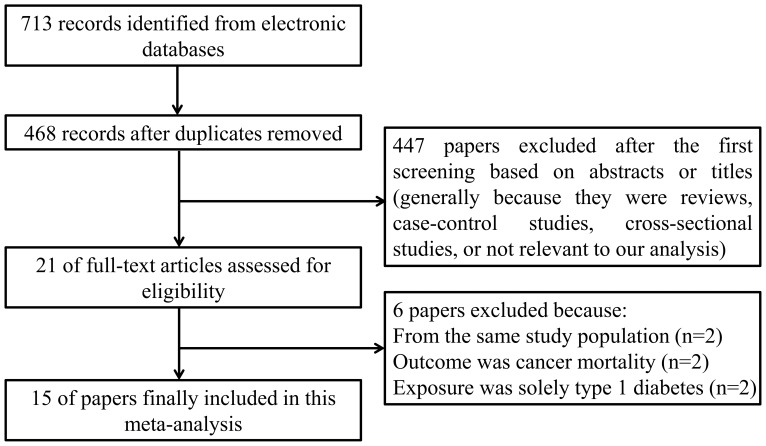
Flowchart of study assessment and selection.